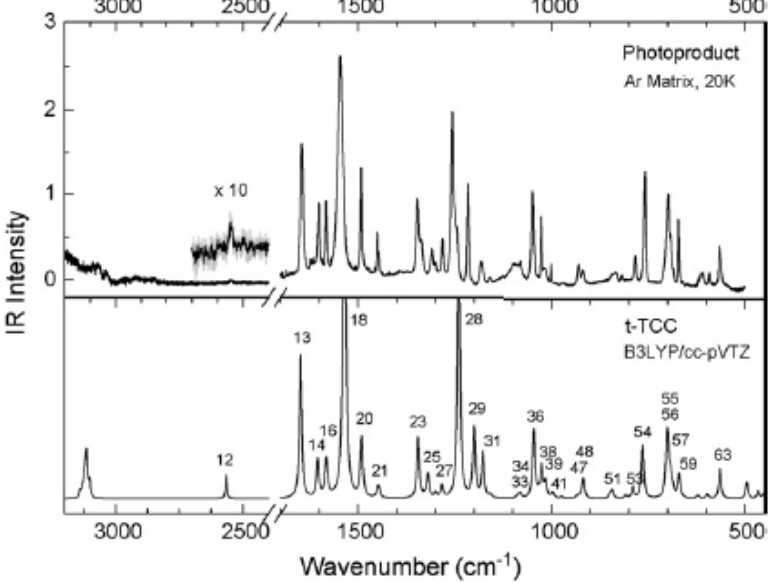
for 10, 20, and 30 min. Taken from Ref. [84] with permission from Elsevier.